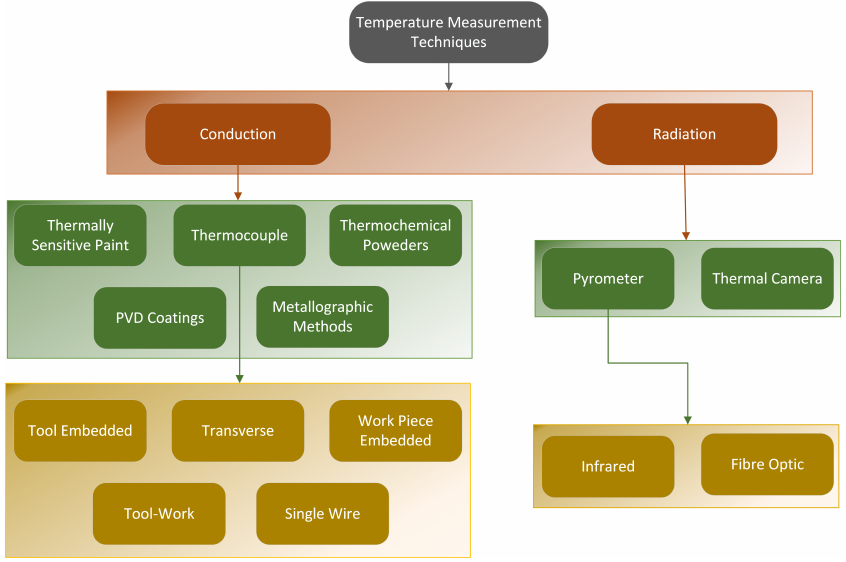
Figure 2. Temperature measurement techniques based on Byrne